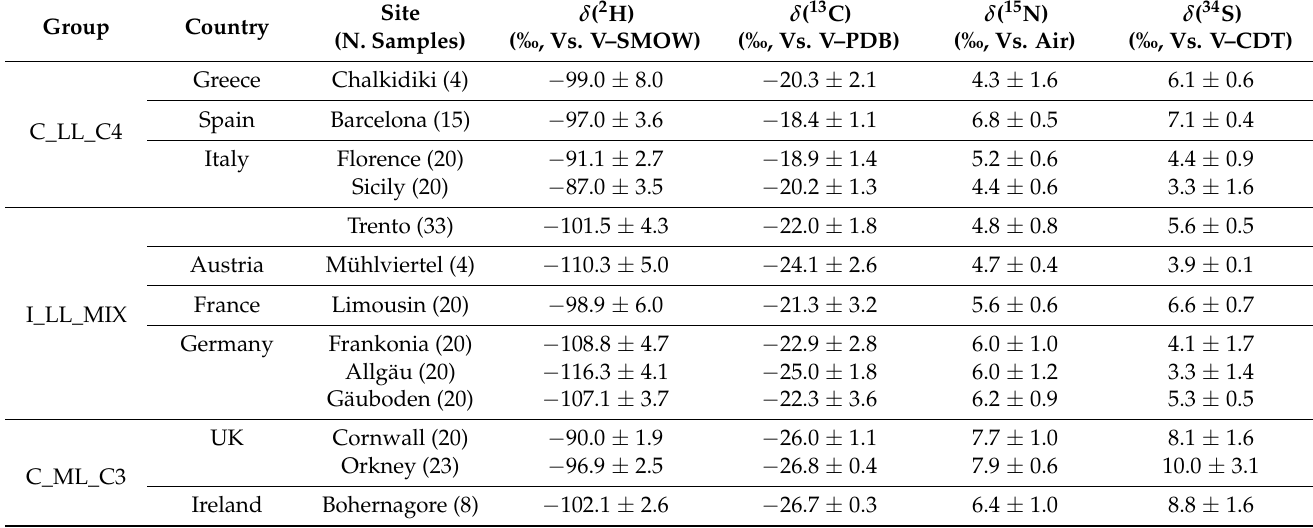
Table 1. Mean δ ( 13 C), δ ( 15 N), δ ( 34 S), and δ ( 2 H) of bovine muscle protein and standard deviations for the 13 European sites considered. The dataset has been divided in three groups: C_LL_C4 (animals from coastal areas, sited at relatively low latitudes, given a C4-based diet); I_LL_MIX (animals coming from inland areas sited at relatively low latitudes, given a mixed diet); C_ML_C3 (animals from coastal areas sited at higher latitudes compared to the other groups, given a C3-based